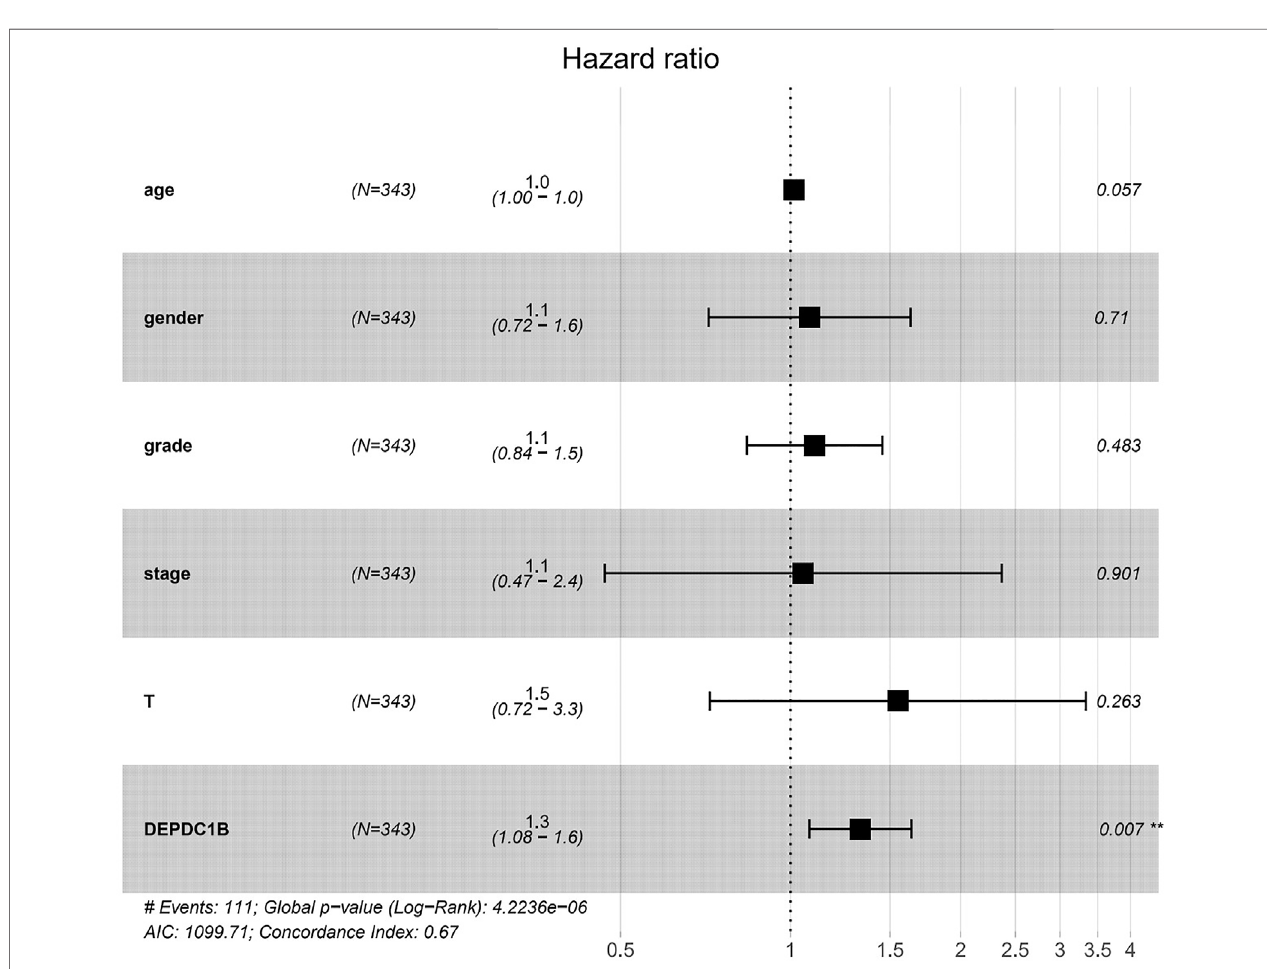
FIGURE 3 | DEPDC1B is an independent risk factor for OS among LIHC patients using multivariate Cox analysis. ** p (cid:1) 0.007.